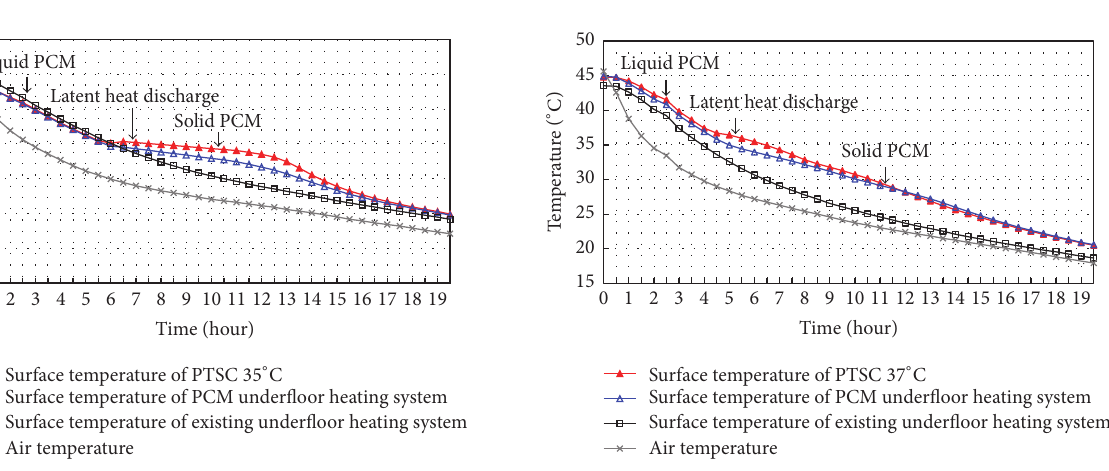
Figure 8: Surface temperatures of existing underfloor heating system and PUFHS with PTSC 37 ∘